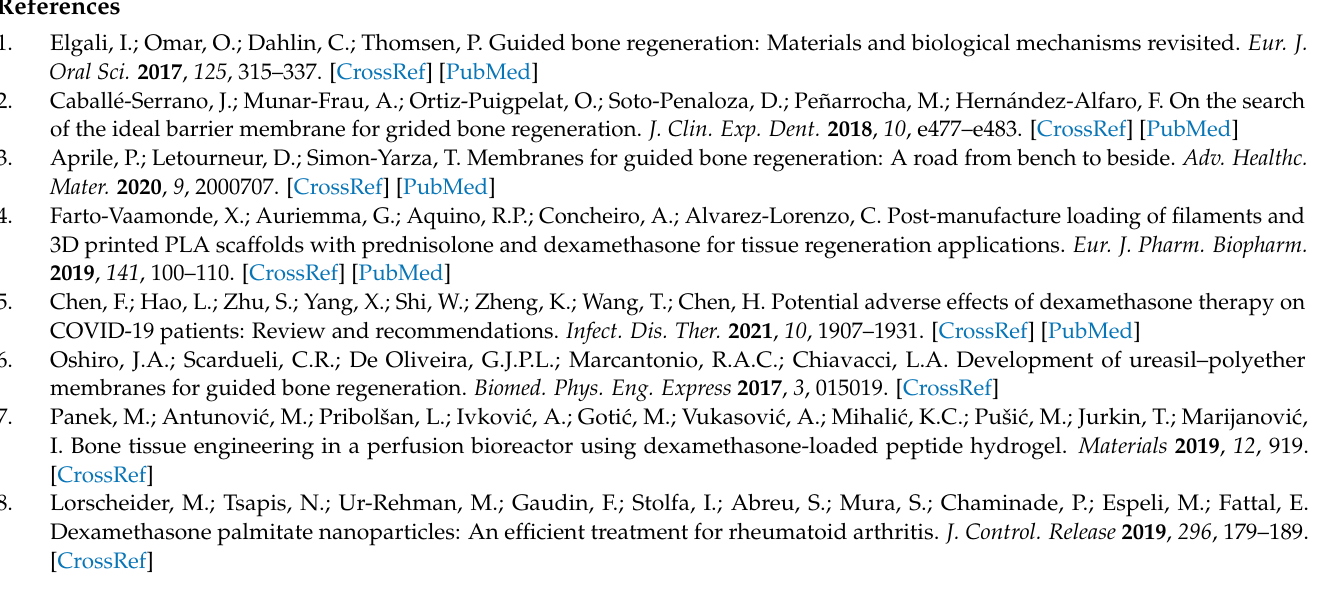
Table S2. Korsmeyer-Peppas equation parameters for the different dexamethasone release curves